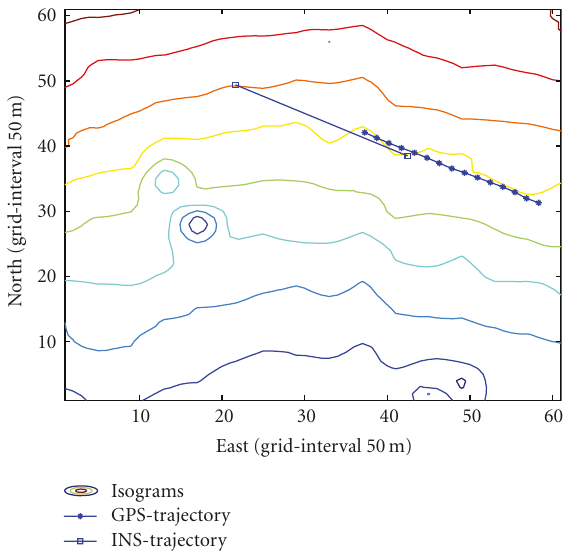
Figure 10: Comparison between the real-measurement sequence and the processed sequence with a constant di ff erence removed for cross-validation.